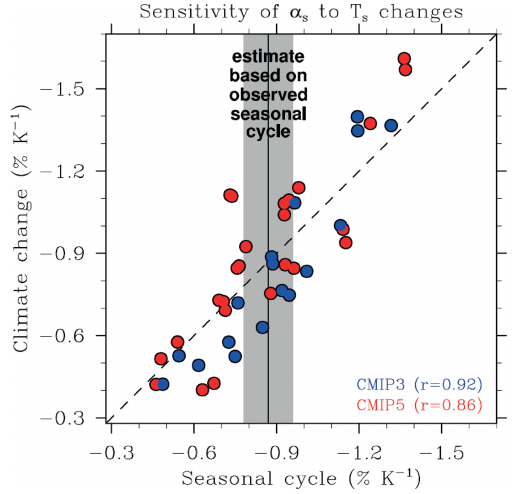
Figure 19. Change in the “sensitivity” of surface albedo (cid:49)α s over change in surface temperature (cid:49)T s of the Northern Hemisphere landmasses ( (cid:49)α s /(cid:49)T s ) in terms of climate change ( y axis) versus in terms of the seasonal cycle ( x axis). Blue: results for different models in CMIP3 including the correlation coefficient for best fit. Red: same for CMIP5. Each blue and red dot represents one model run with one specific ESM. The vertical black line indicates the observed value for the seasonal cycle; the grey shading indicates the uncertainty of the observation-derived value. Source: Klein and Hall (2015), who redrew their figure from Hall and Qu (2006) and Qu and Hall (2006). Reprinted by permission from: Springer, Klein, S. A. and A. Hall: Emergent Constraints for Cloud Feedbacks, Curr. Clim. Change Rep., 1, 276–287, ©Springer